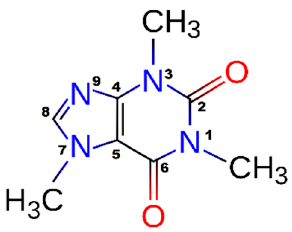
Figure 1. The molecular structure and atomic labeling for caffeine.